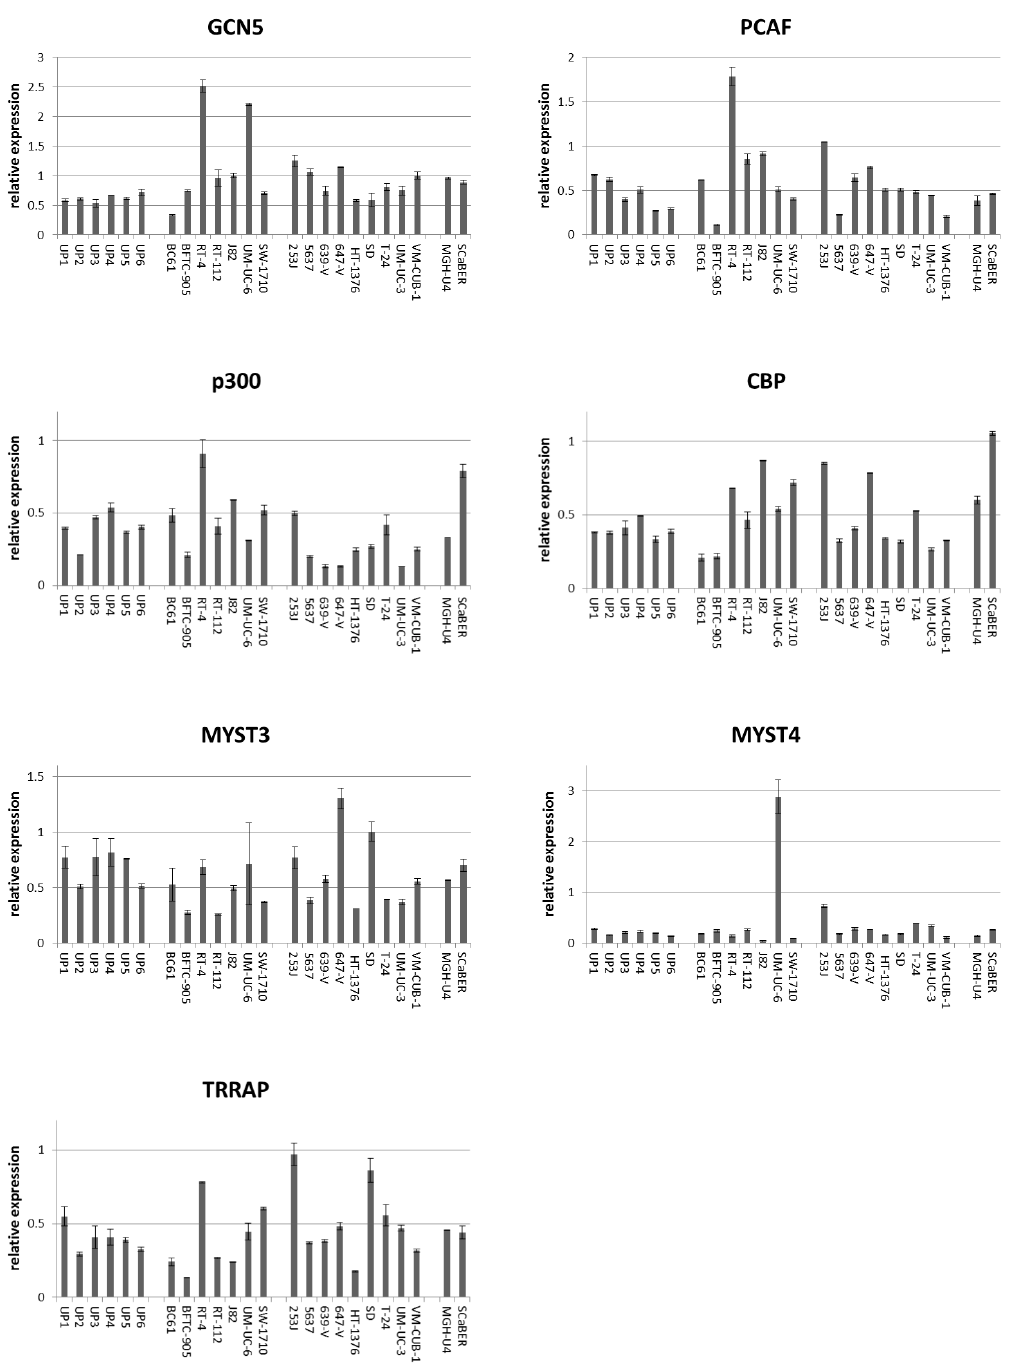
Figure 1. Expression of mRNAs of six histone acetyltransferases (HATs) and TRRAP in normal urothelial cells (UP) and 18 urothelial cancer cell lines. mRNA levels were quantified by qRT-PCR with TBP mRNA as a reference for ( A ) PCAF, ( B ) GCN5, ( C ) p300, ( D ) CBP, ( E ) MYST3, ( F ) MYST4, and ( G ) TRRAP in 6 independent cultures of normal urothelial cells and 18 urothelial carcinoma cell lines (UCCs). Note the low expression of PCAF in BFTC-905, low expression of p300 in 639-V, 647-V and UM-UC-3, and high expression of MYST4 in UM-UC-6. Characteristics of the UCCs are summarized in Table S1.